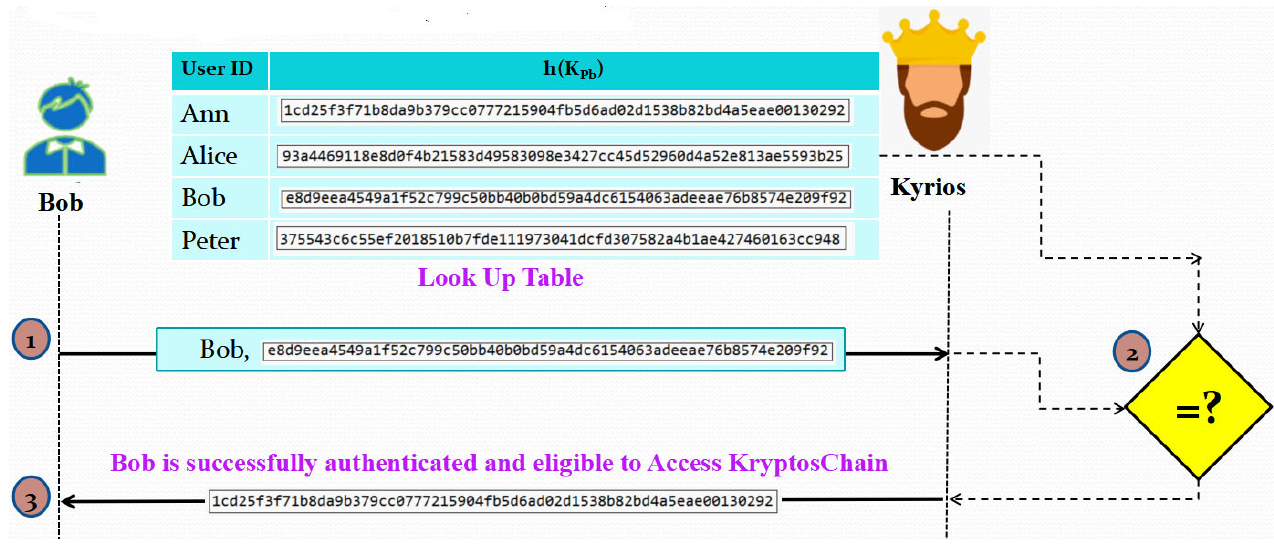
Figure 13. Demonstration of Phase 3: Genesis Block Generation Process.